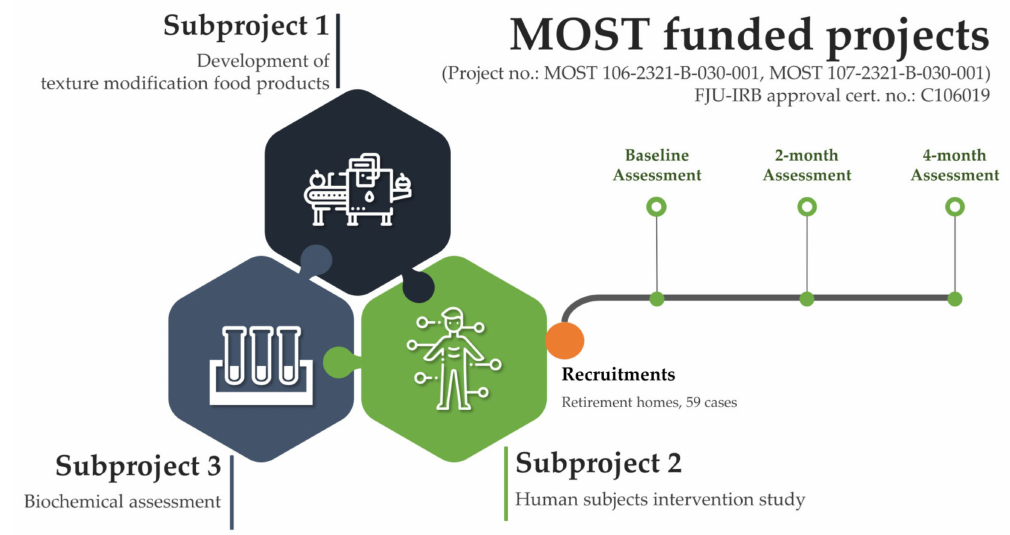
Figure 1. Data acquisition and study